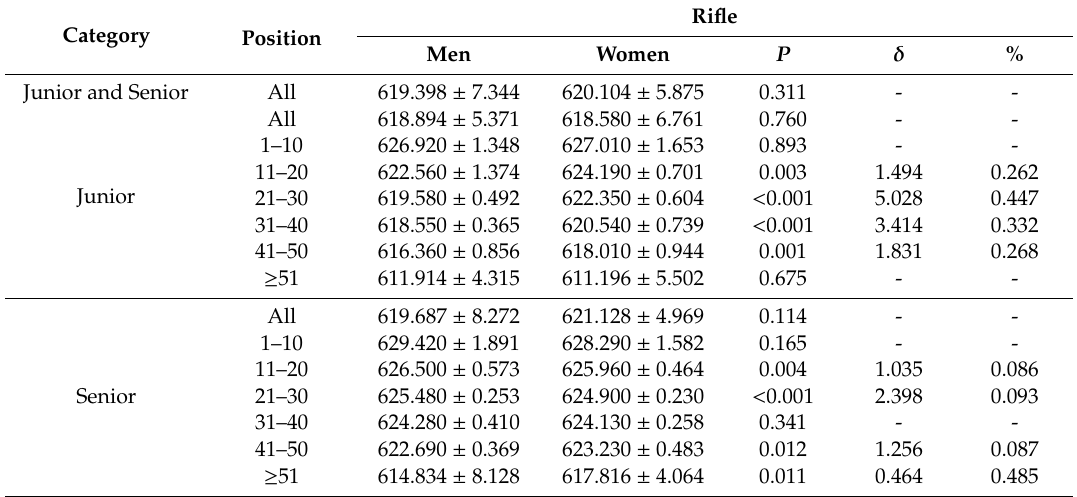
Table 3. Performance contrast between men and women in rifle event.